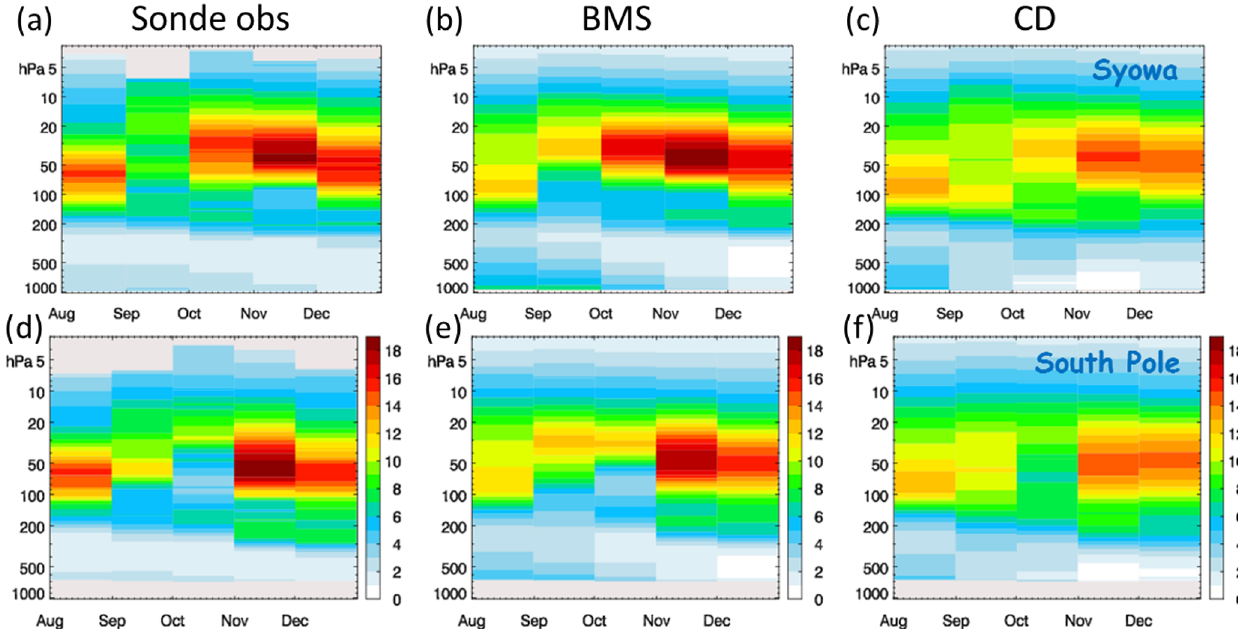
Figure 3. Monthly averaged time series of vertical profiles of ozone (mPa) over the Southern Hemisphere stations of Syowa (69 ◦ S, 40 ◦ E) (a–c) and the South Pole (90 ◦ S) (d–f) . Period shown is August–December 2002, corresponding to the first Antarctic vortex split and ozone hole recovery